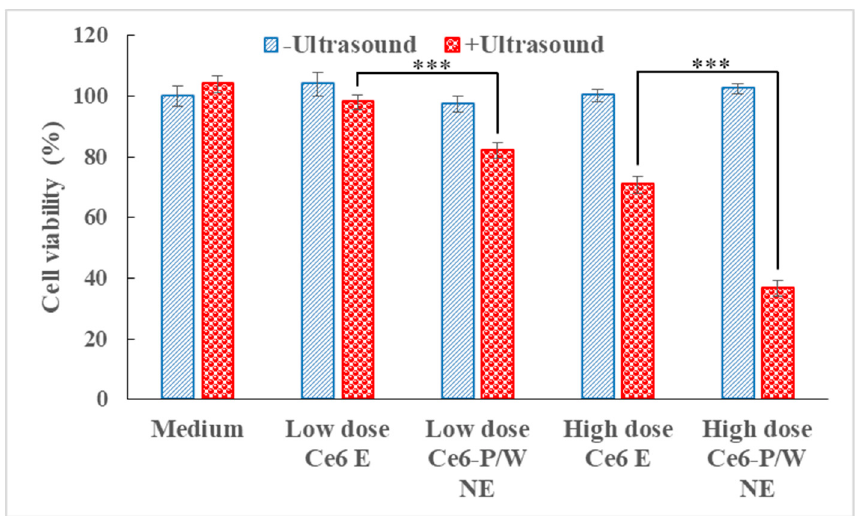
Figure 3. Cell viabilities after incubation with the culture medium, Ce6 Es, or Ce6-P/W NEs with/without ultrasound irradiation (0.25 W/cm 2 , 2.1 MHz, 1 min). Data were presented as mean value ± standard deviation. After Levene’s test for equality of variances, one-way analysis of variance (ANOVA) and Bonferroni multiple comparison test was employed for the comparison of mean values. n = 3. ***, p < 0.001. “Low dose” and “high dose” refer to Ce6-P/W NE concentrations (calculated as the weight of the entire nanodroplet including Pluronic Mn 2900 and PFPE divided by total volume) at 200 μ g/mL (Ce6 concentration, 4 μ g/mL) and 400 μ g/mL (Ce6 concentration, 8 μ g/mL), respectively. The Ce6 Es contain equal amount of chlorin e6 as Ce6-P/W NEs. Ce6 E, chlorin e6 emulsion. Ce6-P/W